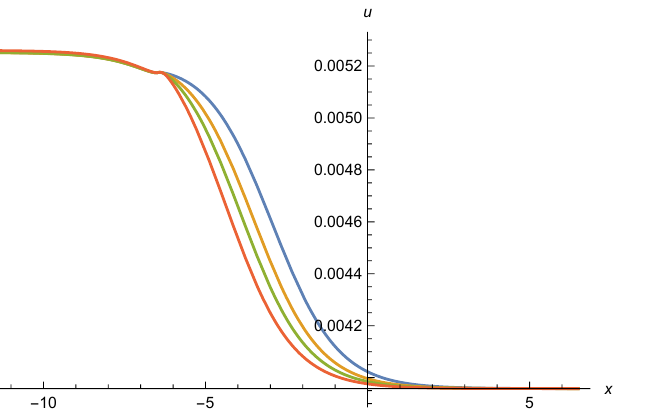
Figure 13. Effective potential u as function of x = ln ˜ ρ . We display curves for four different values ξ ∞ = 0.405 (blue), ξ ∞ = 0.7 (orange), ξ ∞ = 1.0 (green), and ξ ∞ = 1.5 (red), from top to bottom. Initial values as set at ˜ ρ as = 1000 and the particle content is given by N S = 1, N V = N F = 0.